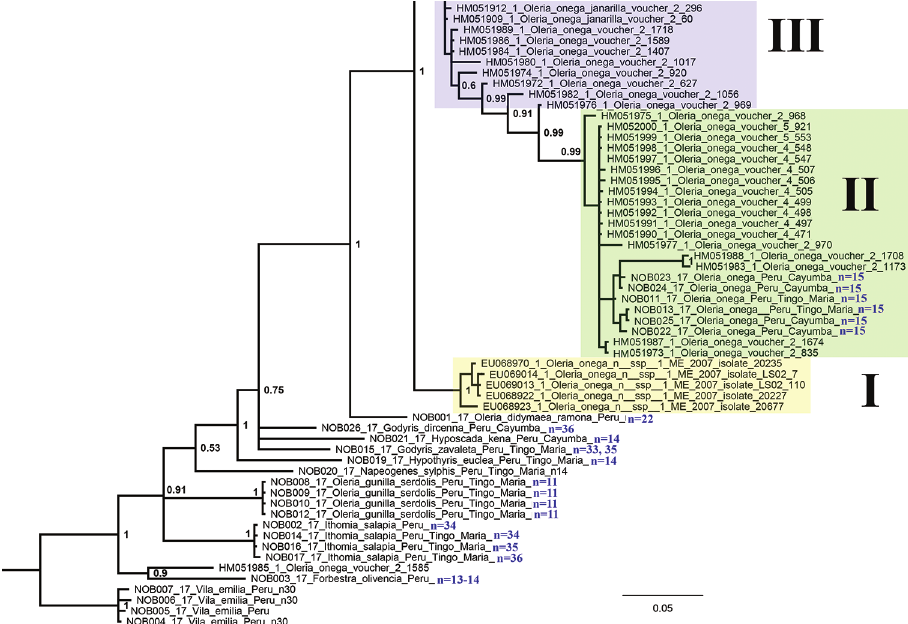
Figure 20. Fragment of the Bayesian majority rule consensus tree of the analyzed samples of Ithomiini inferred from COI sequences. I, II and III are the recovered clusters of the Oleria onega species complex (see Fig. 21 for the complete structure of the cluster III and the cluster IV). Haploid chromosome num- bers (n) are shown after the tip labels. Vila emilia (subfamily Biblidinae) was used to root the tree. Bayesian posterior probabilities higher than 0.5 are shown next to the recovered